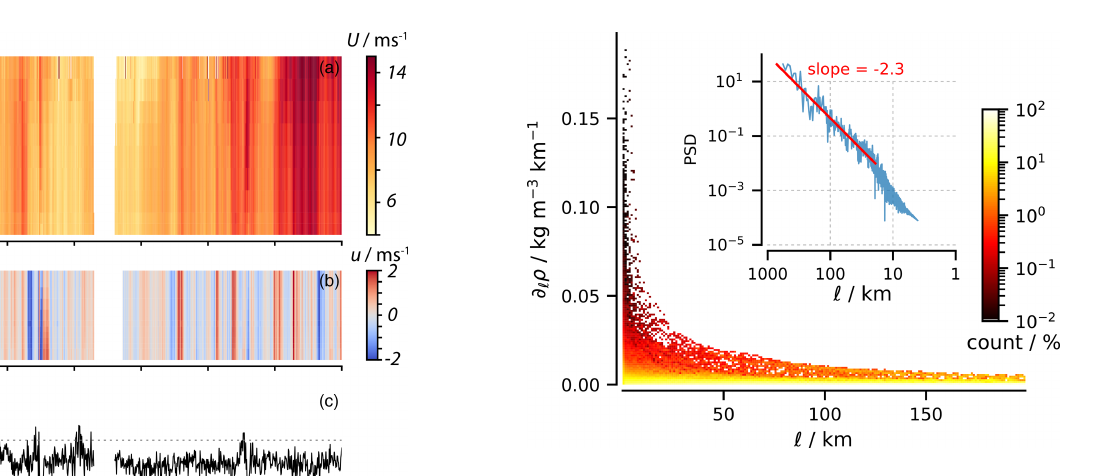
Figure 15. Surface density gradients at different horizontal length scales. Bivariant histogram shows counts versus (1 to 200km) and strength of gradient as measured by Saildrones (note the log-scale color bar). Inset is power spectral density of the surface density gra- dients, calculated by averaging periodograms constructed for each vehicle after de-trending the data and smoothing the data with a 2km Gaussian filter. The red line shows the linear regression best fit slope of − 2 .